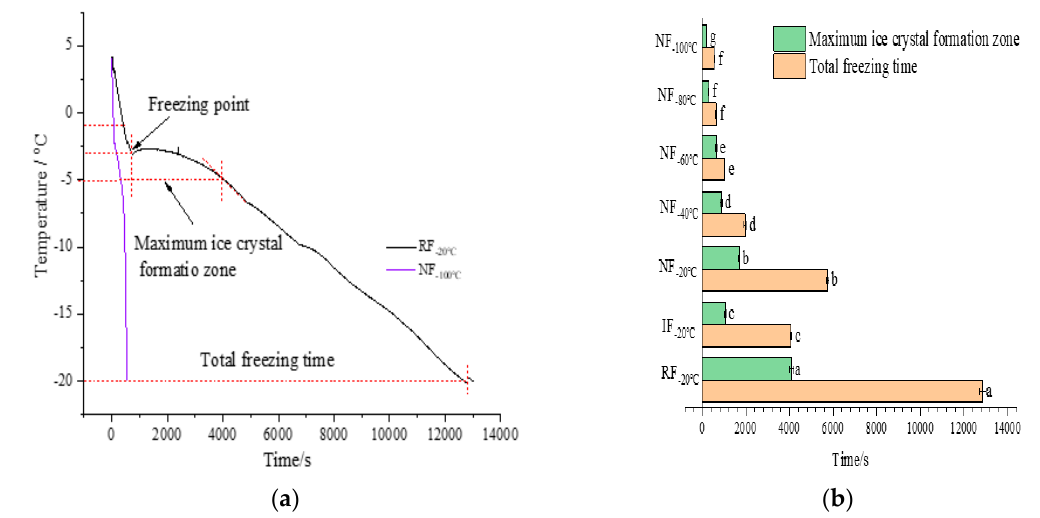
Figure 1. Comparison of freezing times of blueberry under different freezing processes: ( a ) freezing curve ( b ) freezing time. Note: In this paper, the different letters above the histogram represent the significant difference of each group of one style treatment ( p < 0.05).